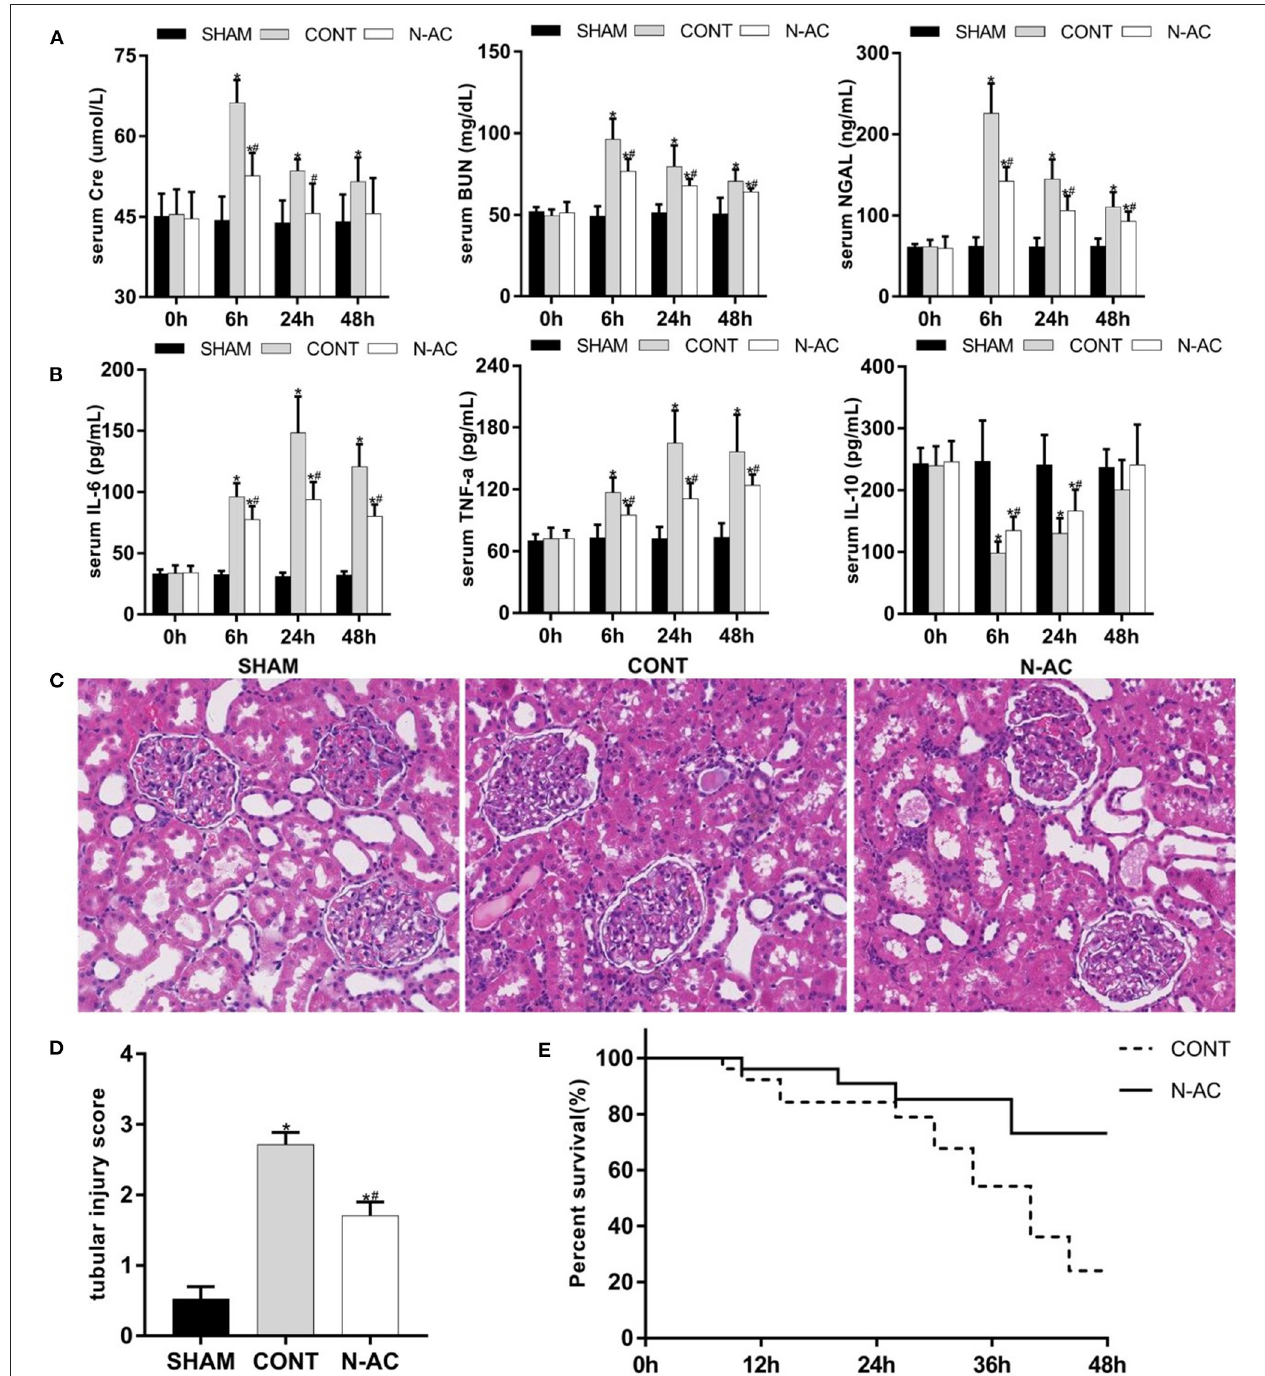
FIGURE 8 | N-AC exert renal protective effects and improve survival rate at 48h after ROSC. (A) The dynamic changes of renal function in each group. (B) The dynamic changes of inflammatory response in each group. (C) Pathological changes in the kidneys. (D) Quantitative dates of TIS. (E) The Kaplan-Meier survival curves of control group and N-AC group. SHAM, sham group; CONT, control group; N-AC, N-AC group. Sham group, n = 5; Control group, n = 20; N-AC group, n = 20. Data are expressed as mean ± SD. * P < 0.05, vs. sham group; # P < 0.05, vs. control group.